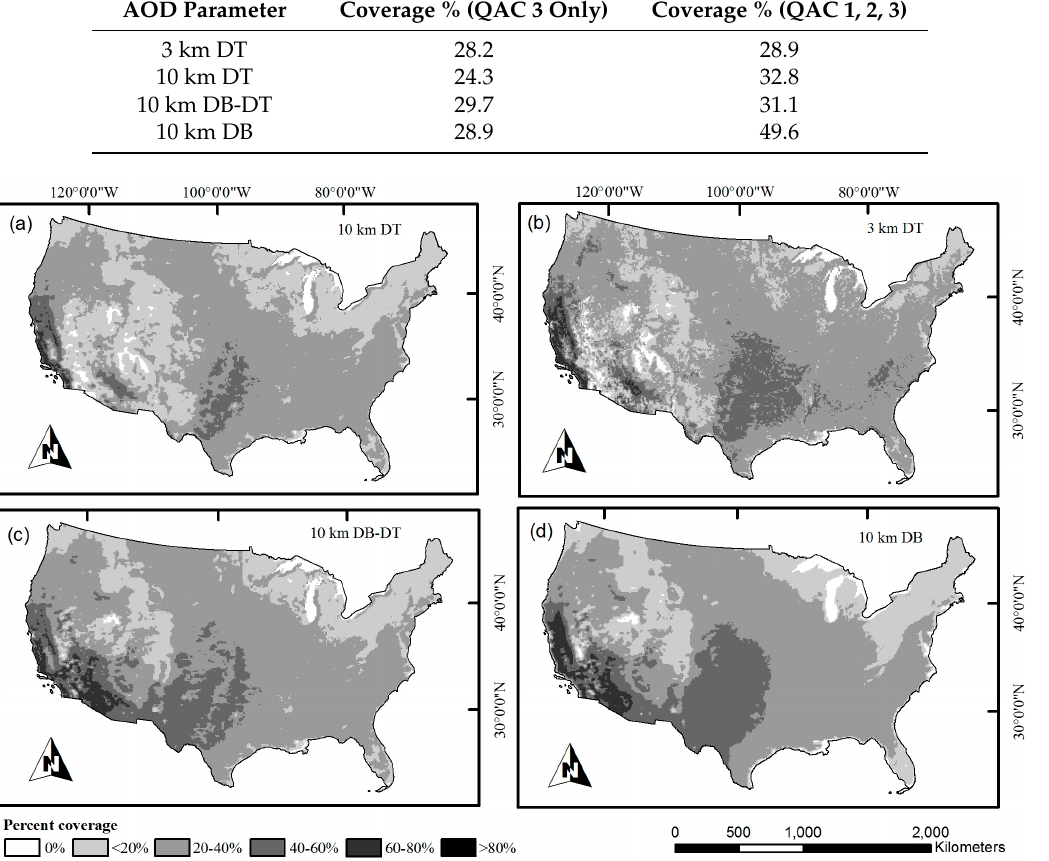
Figure 2. Mean coverage statistics for high confidence AOD retrievals in the CONUS for 10 km DT ( a ); 3 km DT ( b ); 10 km DB-DT ( c ); and 10 km DB ( d ). Coverage is calculated as the percentage of days between 1 January 2004 and 31 December 2013 with a valid MODIS retrieval from Aqua.